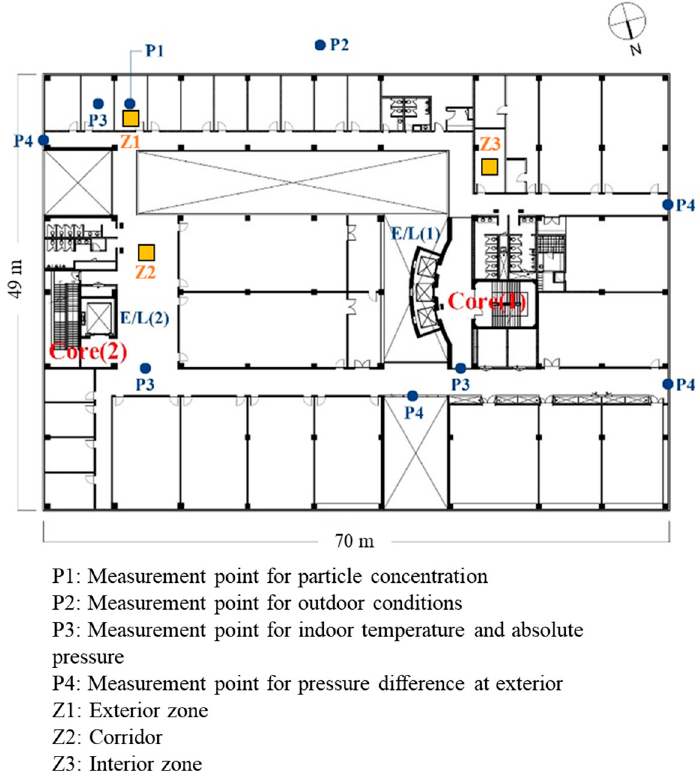
Figure 6. Floor plan of the reference building.